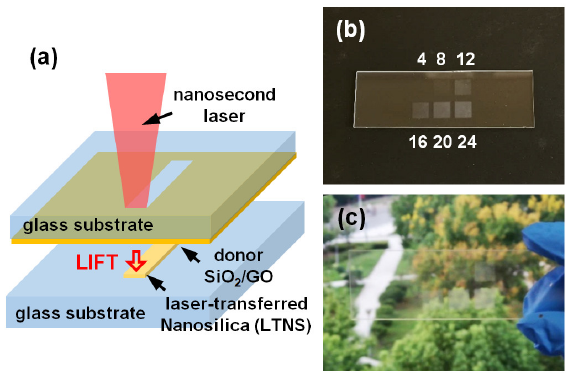
Figure 1. ( a ) Schematic diagram of the processing system; ( b , c ) show the photographs of laser-transferred nanosilica (LTNS).